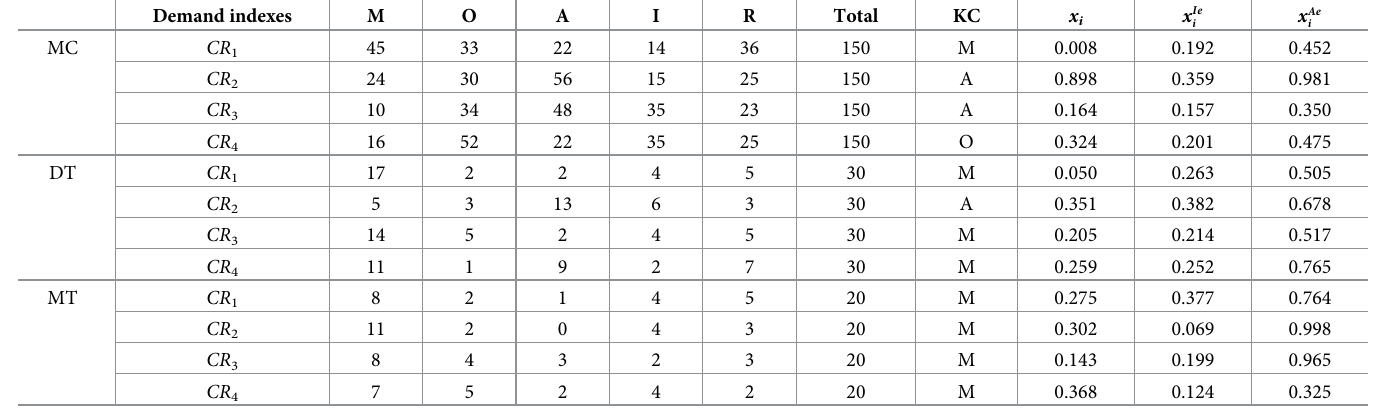
Table 6. Demand classification and evaluation